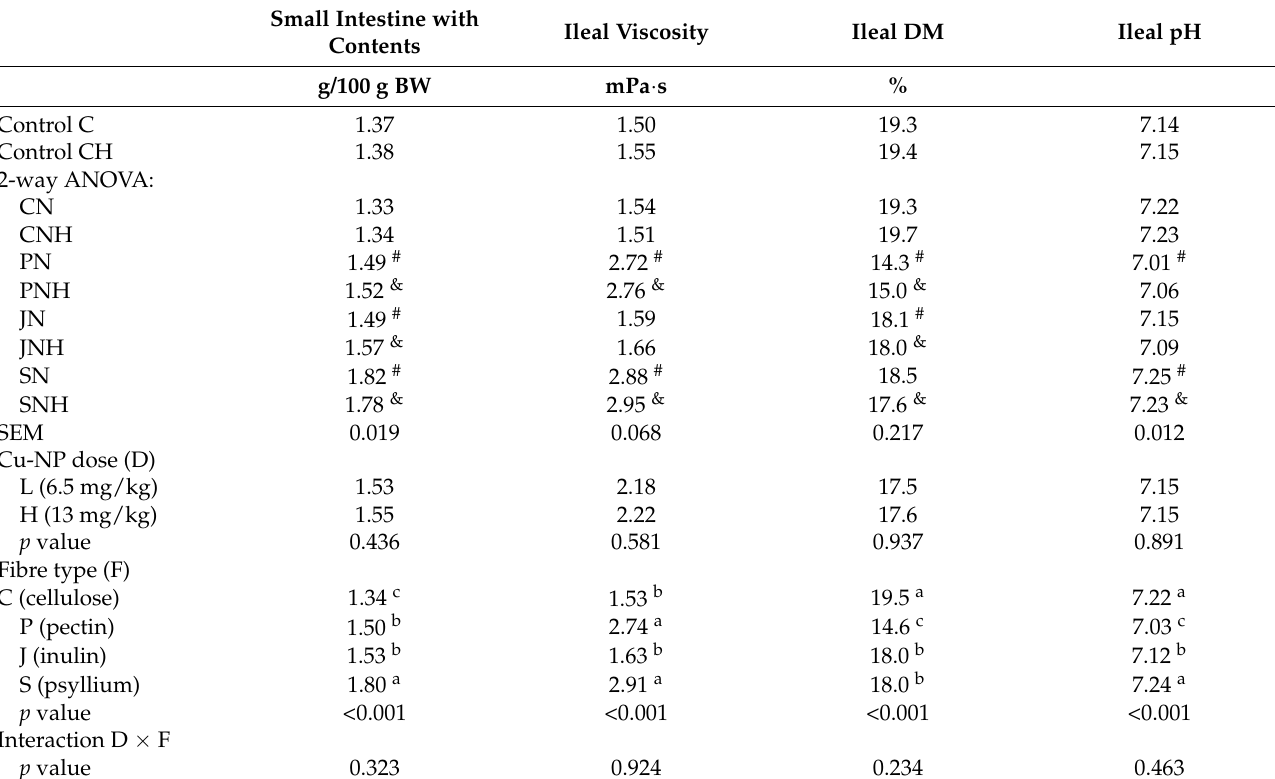
Table 4. Intestinal parameters in rats fed experimental diets (n = 10 per group) *.